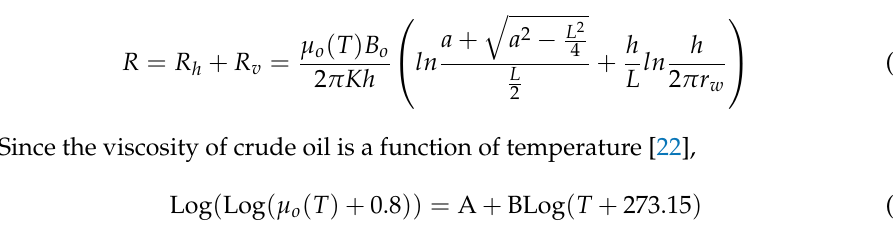
Figure 8. Comparison of oil production rate for conventional CSS and E-CSS. ηρ o C o ( T s − T R ) s is the slope of the relationship curve of 1 and t 4 , which is the limit Q ( t ) q o ( t ) on the rate of yield decline. For conventional CSS, the heat injected into the oil layer Q is the enthalpy Q s of the injected steam. For E-CSS, the heat injected into the oil layer Q is the enthalpy Q s of the injected steam and the enthalpy Q e ( t 4 ) of the electric heating input. ( T s − T R ) s To sum up, the decreasing rate of conventional CSS is ηρ o C o , and the decrement Q s ( T s − T R ) s rate of E-CSS is ηρ o C o . Since Q e ( t 4 ) increases with time, the slope value decreases Q s + Q e ( t 4 ) with other parameters unchanged, so the decline rate of output decreases with time. The enthalpy of steam injected into the first 1, 2, 3, 4 CSS cycles was 952,700 J, and the enthalpy of the electric heating input oil layer was 1,277,075 J, 2,899,011 J, 2,980,319 J, 2,980,250 J, respectively. Based on the calculation, the decline rate of E-CSS of the 1,2,3,4 only accounts for 42.7%, 24.7%, 24.2% and 24.2% of conventional E-CSS. (3) The effect of electric heating on the porous flow resistance to the well. In the process of CSS in the horizontal well, the porous flow resistance of the fluid at any point in the horizontal section R is equal to the sum of the horizontal porous flow resistance R h , and the vertical porous flow resistance R v :